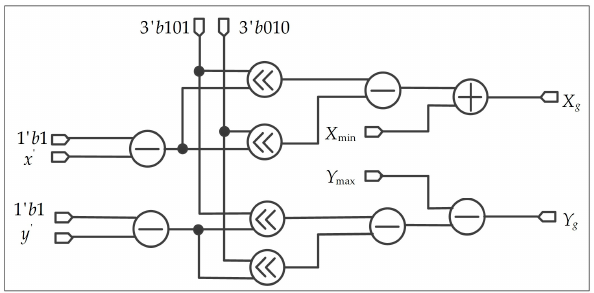
Figure 15. Parallel computation method for X g and Y g .